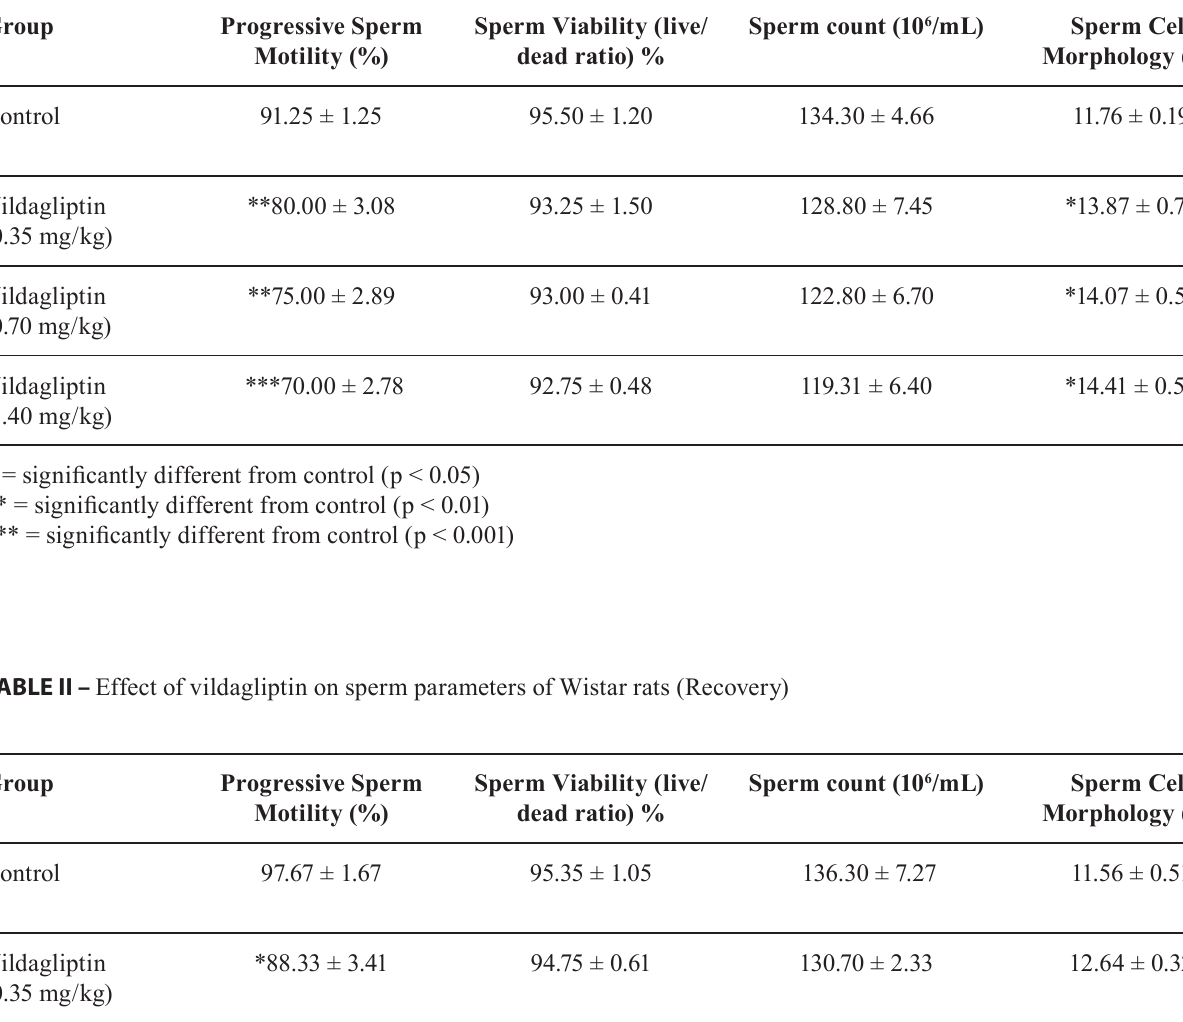
TABLE I – E ffect of vildagliptin on sperm parameters of Wistar rats (Experimental)